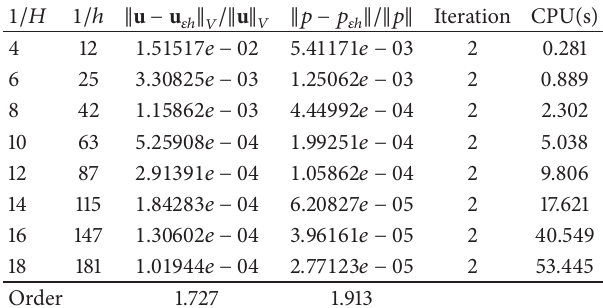
Table 4: Numerical relative error for Stokes method.